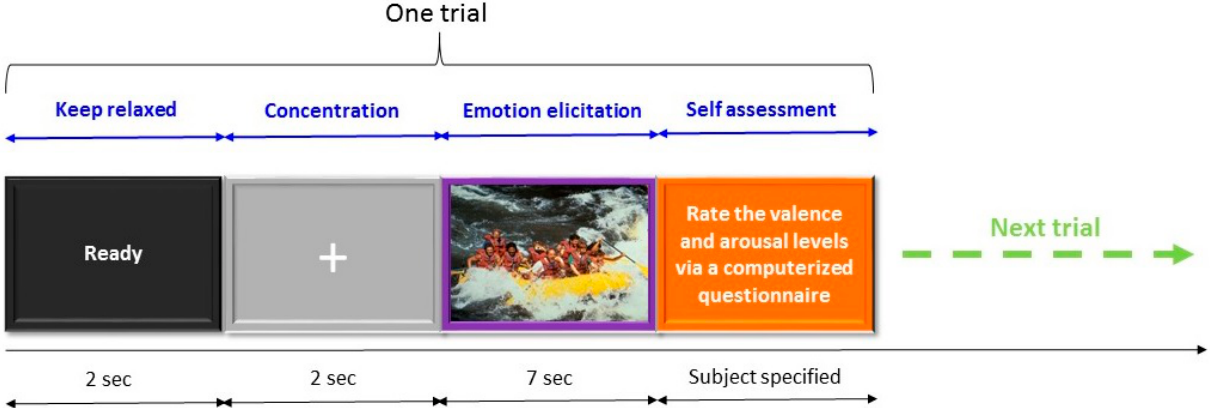
Figure 4. Emotion induction paradigm designed used for collecting EEG data.